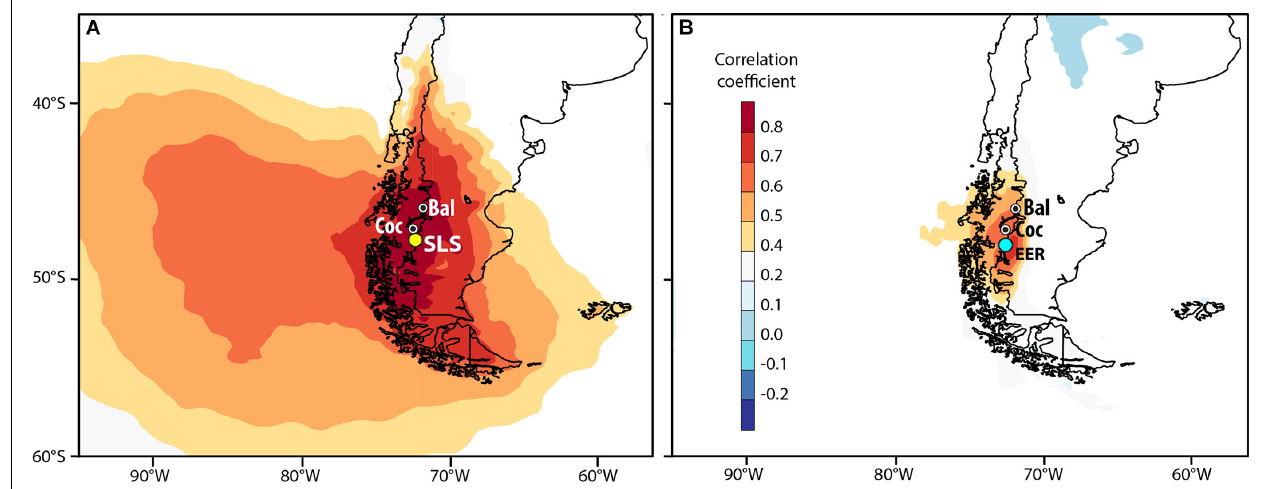
FIGURE 2 | Location of meteorological stations and spatial correlation patterns between monthly anomalies of (A) temperature in San Lorenzo Sur (San Lorenzo Sur), (B) precipitation in Estancia Entre Ríos (EER), and the corresponding anomalies in